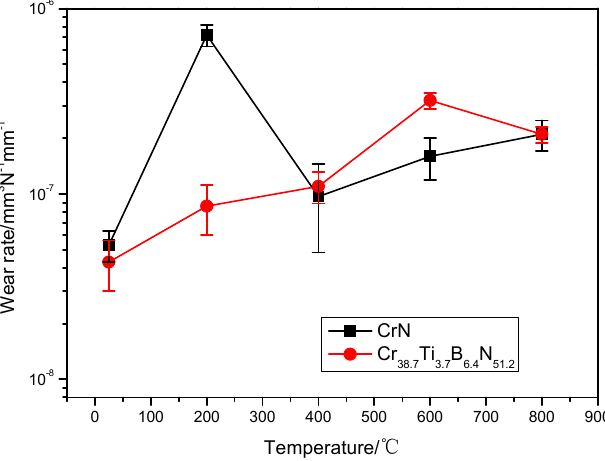
Figure 10. Wear rate of CrN film and Cr 38.7 Ti 3.7 B 6.4 N 51.2 composite film at different temperature.